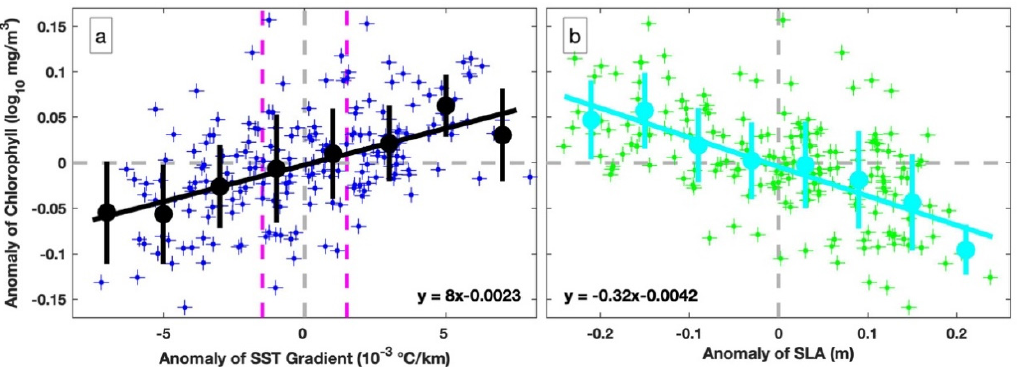
Figure 8. Scatterplots of Chl-a (log 10 (mg/m 3 )) versus ( a ) SST gradient (°C/km) and ( b ) SLA (m) in the anomalous field. In ( a ), black dots are the averaged Chl-a for each bin of the SST gradient, with vertical bars representing the corresponding standard deviation. Similarly, in ( b ), cyan dots are the averaged Chl-a for each bin of SLA. The solid lines are obtained using linear regression between the values of bins and bin-averaged Chl-a, and both of them are significant at the 95% confidence level. The obtained regression is labeled in the corresponding panel. Dots between the magenta dashed lines in ( a ) represent small magnitudes of the SST gradient.